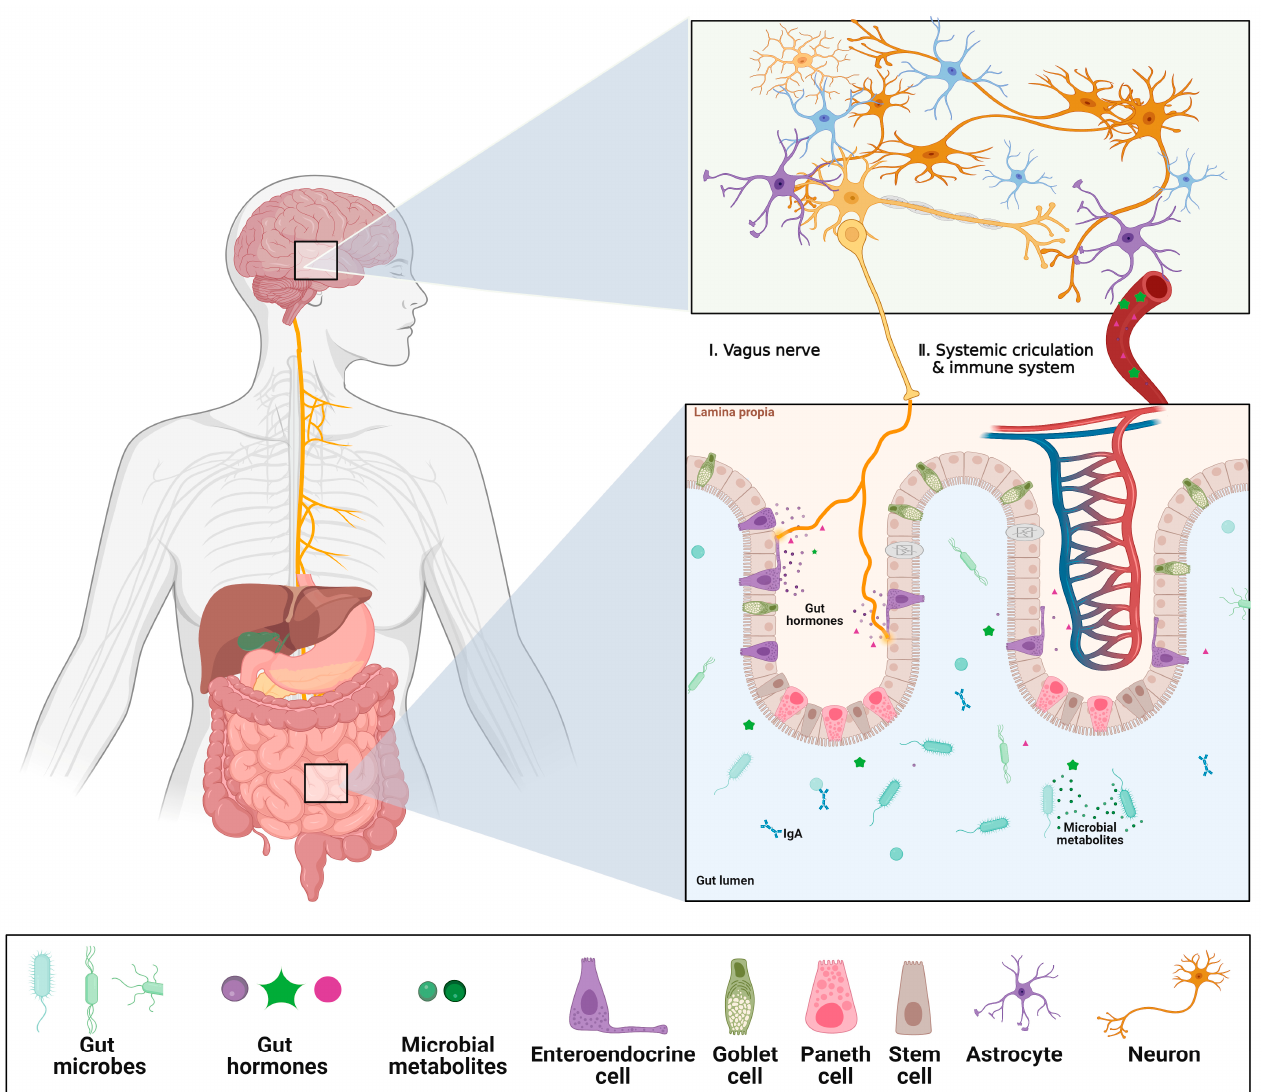
Figure 4. Schematics of Gut–Brain Axis (GBA). The gut luminal environment, including the gut microbiome, affects the physiology and behavior of the brain via multiple routes. ( I ) The vague nerve senses gut hormones and microbial metabolites from the gut environment and delivers the signals to the brain. ( II ) Microbial products can cross the gut epithelial barrier, which makes them eventually enter systemic circulation. Additionally, some gut hormones are secreted into the bloodstream, stimulating the immune system, or traveling to the BBB, which affects changes in the physiology and behavior of the BBB and brain. Created with BioRender.com. The reproduction of this image has been licensed from BioRender.